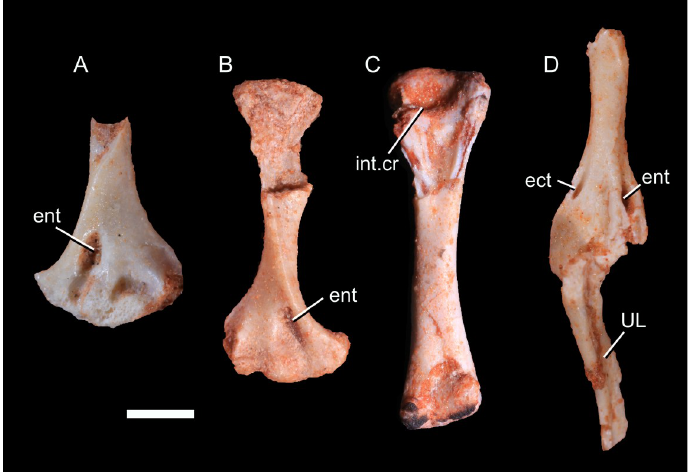
Fig 12. Materials previously cataloged as indeterminate brasilodontids. A , specimen UFRGS-PV-0600-T; B , specimen UFRGS-PV-1361; C , specimen UFRGS-PV-0922-T; D , specimen UFRGS-PV-1042-T, representing a new morphotype of probainognathian. Abbreviations: ect , ectepicondylar foramen; ent , entepicondylar foramen; int.cr , intertrochanteric crest; UL , ulna. Scale bar = 2 mm.